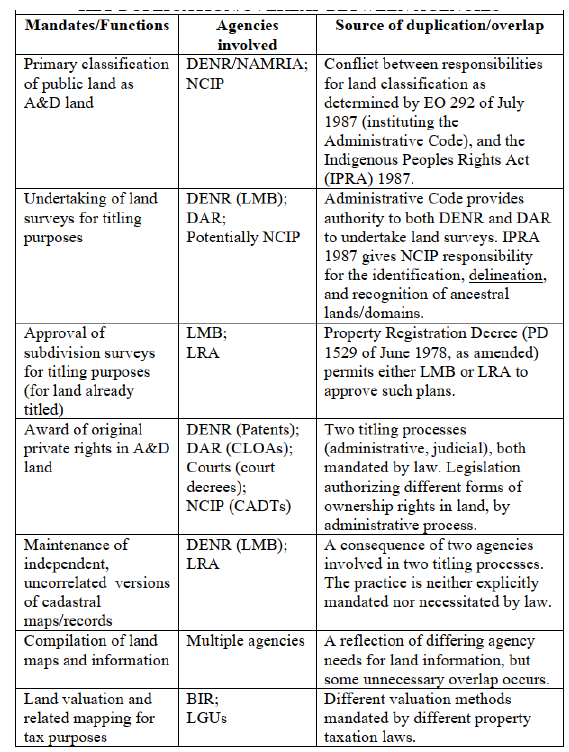
Table 1 . Summary of duplication of functions between land agencies in the Philippines. Source: DENR-LAMP, International Management Policy Study, 2002 as cited by Dealca